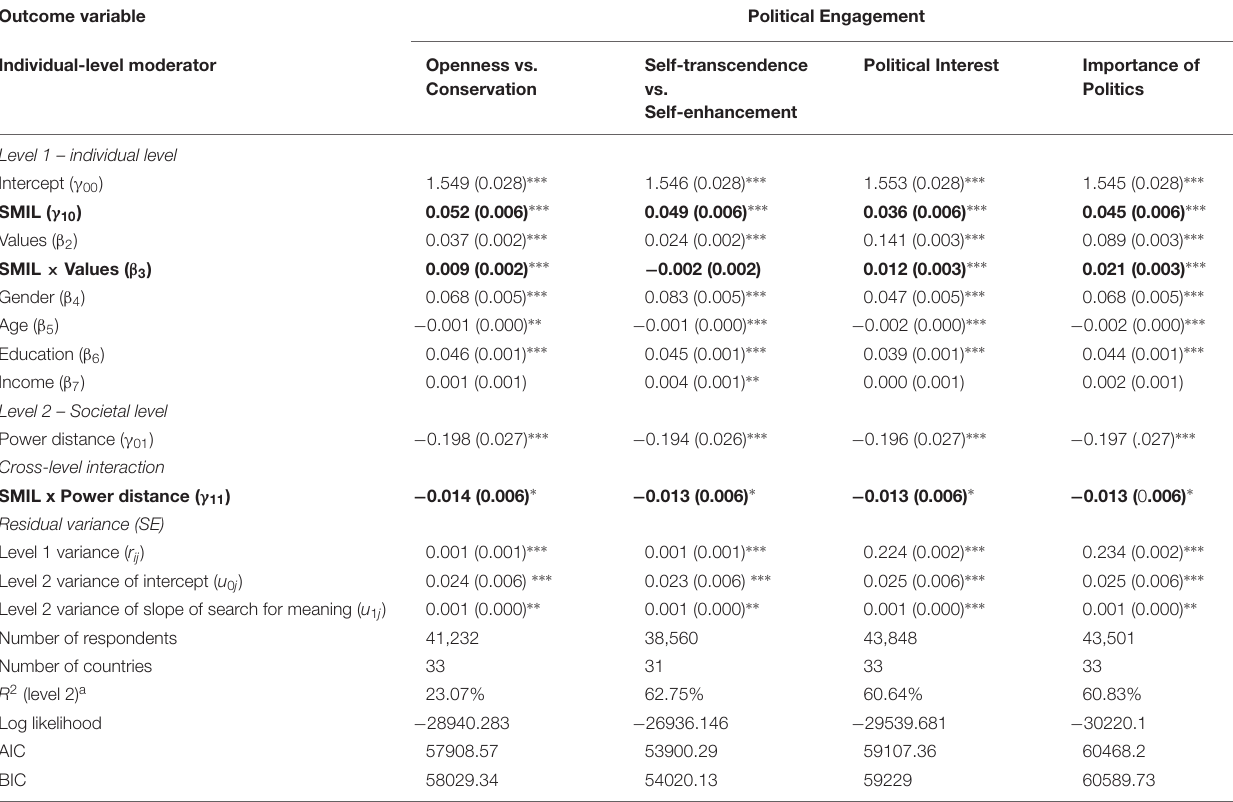
TABLE 2 | Final models of political